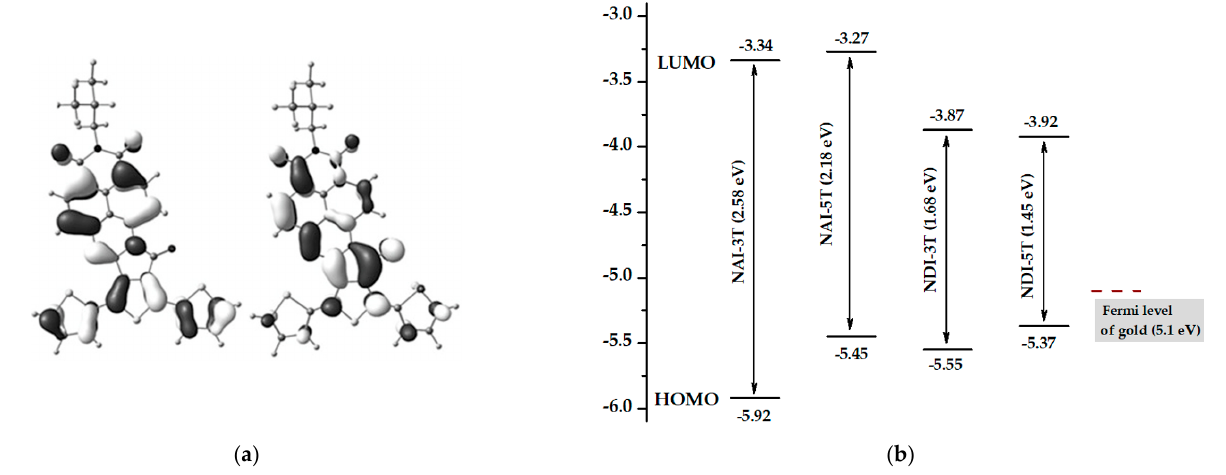
Figure 9. ( a ) LUMO (left) and HOMO (right) molecular topologies obtained by DFT7B3LYP76-31G** for NAI-3T . Adapted with permission from Chem. Eur. J . 2016 , 22 , 13643–13652. Copyright© 2016 WILEY-VCH Verlag GmbH & Co. KGaA, Weinheim, Germany [25]. ( b ) HOMO/LUMO energy levels for oligothiophene–naphthalimide assemblies based on NDI and NAI.